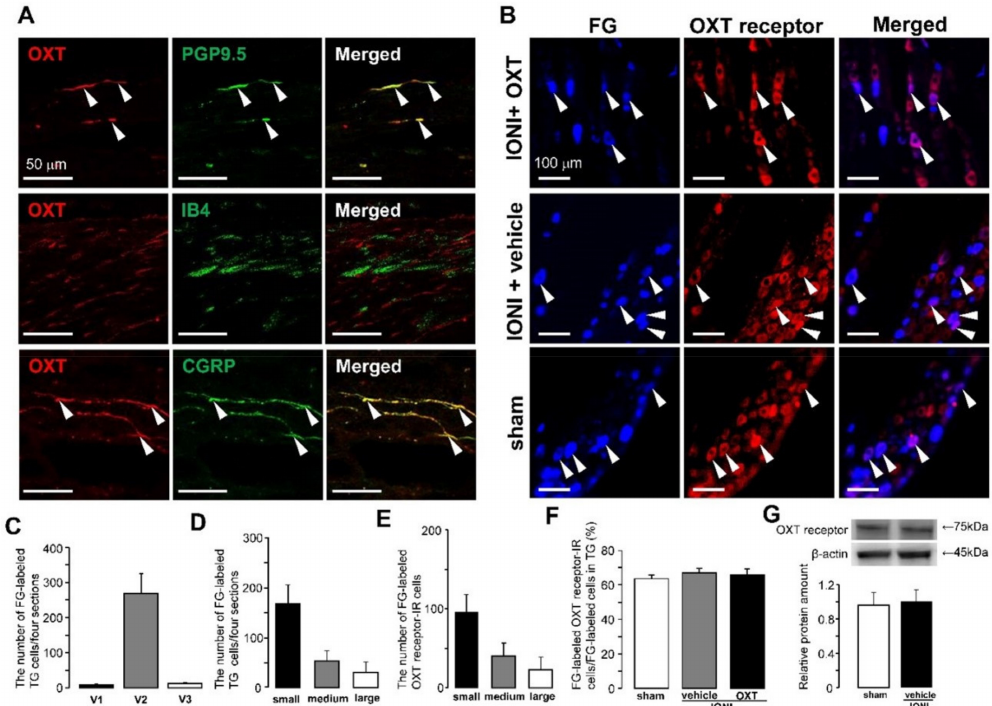
Figure 2. Oxytocin (OXT) receptor expression on day 5 after sham treatment or infraorbital nerve injury (IONI). ( A ) OXT receptor-immunoreactive (IR) nerve a ff erents that express protein gene product (PGP) 9.5, isolectin B4 (IB4), and calcitonin gene-related peptide (CGRP) in the ION bundle on day 5 after sham treatment. Arrowheads indicate OXT receptor-IR and PGP 9.5-IR, IB4-IR, or CGRP-IR nerve a ff erents. Scale bar: 50 µ m. ( B ) Fluoro-gold (FG)-labeled OXT receptor-IR neurons after sham treatment or IONI with vehicle or OXT administration. Arrowheads indicate FG-labeled OXT receptor-IR neurons. Scale bar: 100 µ m. ( C ) The number of FG-labelled neurons in ophthalmic branch division (V1), maxillary branch division (V2), and mandibular branch division (V3) of the trigeminal ganglion (TG) on day 5 after sham treatment. ( n = 4). ( D ) Size-frequency histogram illustrating the distribution of FG-labeled TG neurons on day 5 after sham treatment. ( n = 4). ( E ) Size-frequency histogram illustrating the distribution of FG-labeled OXT receptor-IR TG neurons on day 5 after sham treatment. ( n = 4). ( F ) Mean percentages of FG-labeled OXT receptor-IR TG neurons and FG-labeled TG neurons on day 5 after sham treatment or IONI with vehicle or OXT administration. (sham, n = 4; IONI + vehicle, n = 4; IONI + OXT, n = 5). ( G ) Relative amounts of OXT receptor in TG. (sham, n = 8; IONI + vehicle, n =